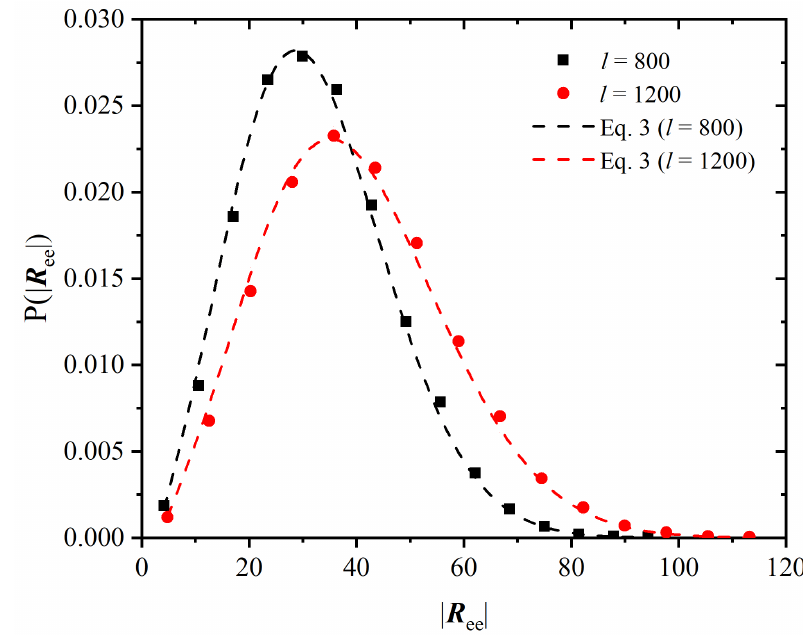
Figure 9. Probability distribution of the modulus of the end-to-end vector, | R ee | averaged over the production phase, Region IV, for chains of lengths l = 800 ± 50 and l = 1200 ± 50 (small intervals of l instead of single values have been used to obtain better statistics), together with the expected distributions according to Equation (2), setting Kuhn length b 0 = 1.52, according to Figure